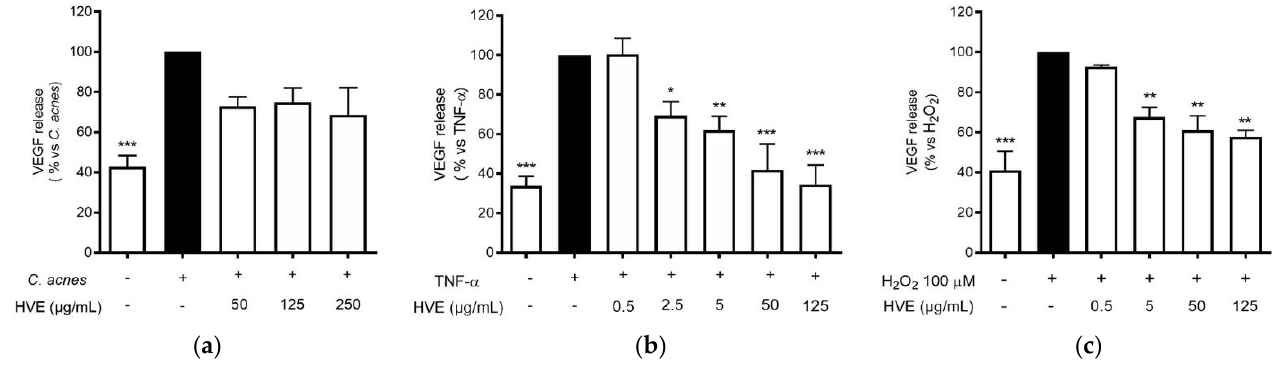
Figure 6. Effect of HVE treatment (0.25 –25 μg /mL) on VEGF release induced by C. acnes ( a ), TNF- α (10 ng/mL) ( b ), or H 2 O 2 (100 μM) ( c ) in HaCaT cells after 24 h. Apigenin (20 μM), representing the reference inhibitor, inhibited VEGF release induced by H 2 O 2 ( − 57%), TNF- α (− 43%), and C. acnes ( − 33%). The amount of VEGF in the presence of TNF- α or C. acnes was 407.48 ± 3.98 pg/mL, and 47.29 ± 2,27 pg/mL in the presence of H 2 O 2. * p < 0.05, ** p < 0.01, *** p < 0.001 vs. stimulus.